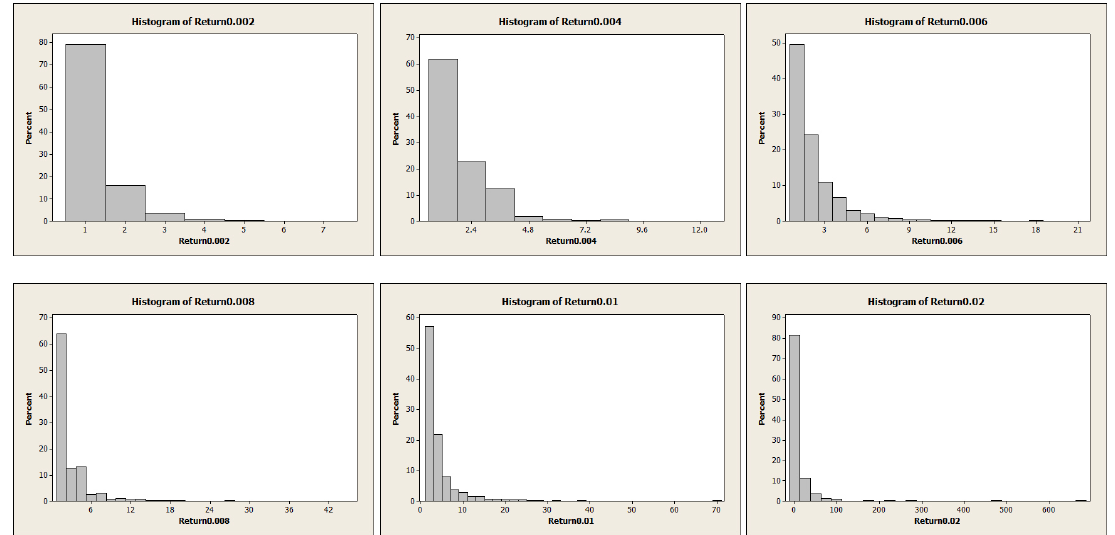
Figure 4. Scatter plots.